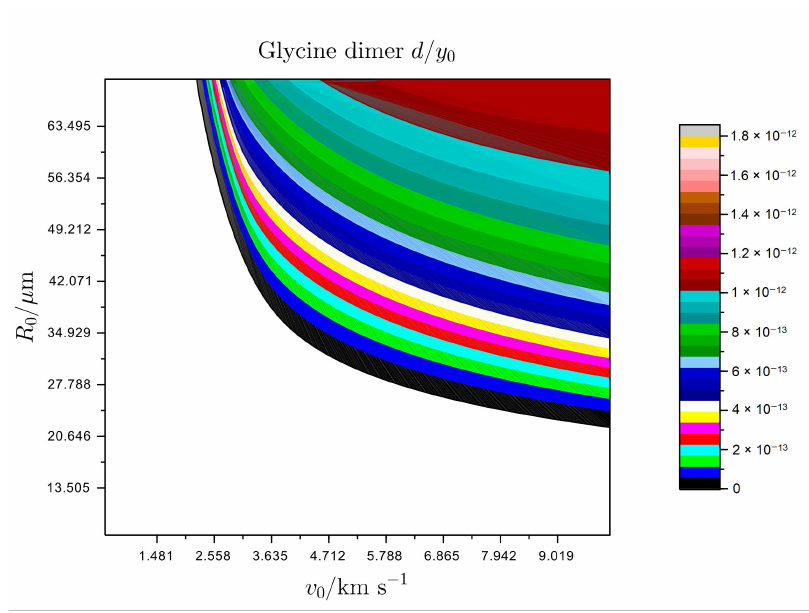
Figure 7. Contour lines of the relative concentration of diglycine d / y 0 (1.69 × 10 − 13 ≤ d / y 0 ≤ 1.69 × 10 − 12 ) calculated with L = 3.574 × 10 − 11 m, D 0 = 1.0 × 10 − 12 m 2 s − 1 , and θ 0 = 45.0 deg versus the initial velocity and radius of micrometeoroids with 0.5 ≤ v 0 ≤ 10.0 km s − 1 and 7 ≤ R 0 ≤ 70 µ